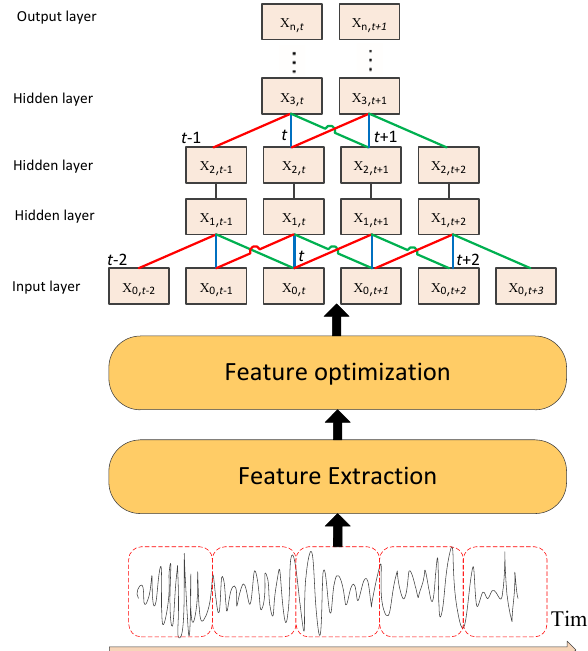
Figure 1. The architecture of Deep Neural Network (DNN) for ship